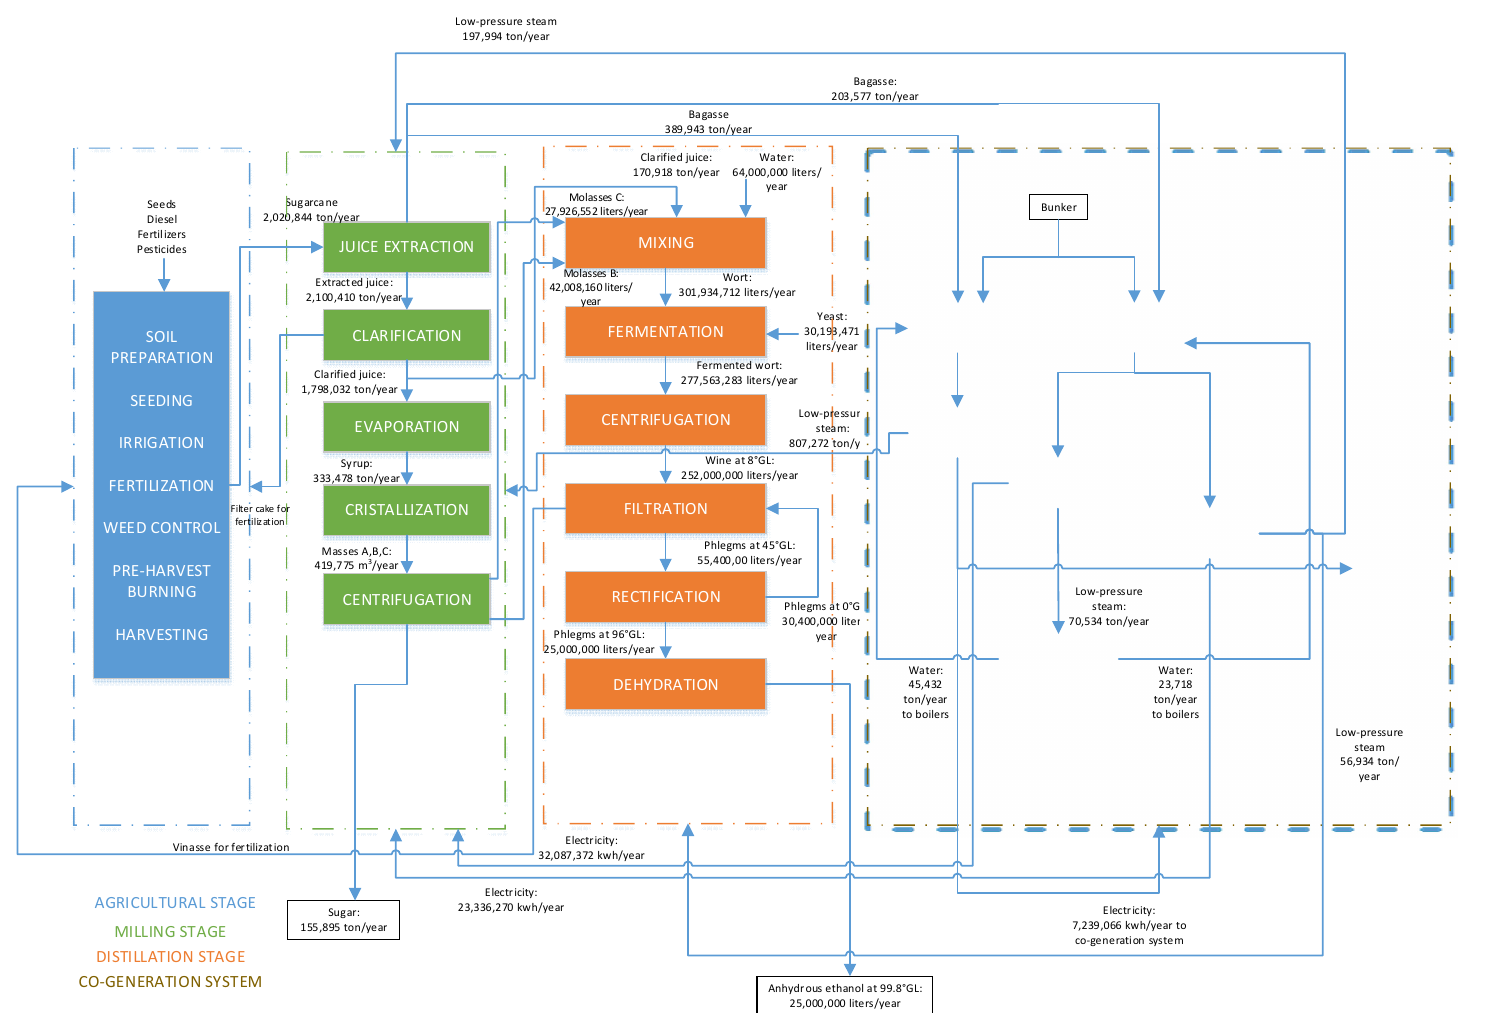
Figure 1. Anhydrous ethanol life cycle system boundaries and main product flows quantification for year 2018.